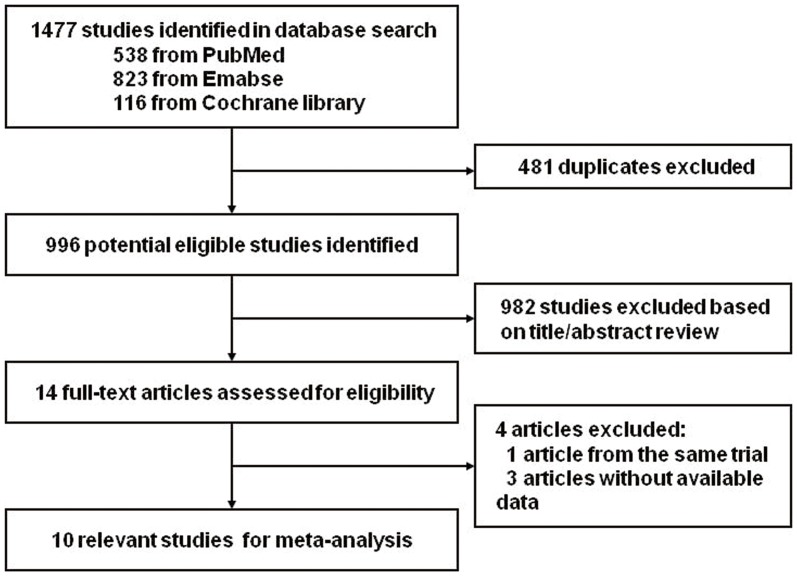
PRISMA Flow Chart.A total of 14 articles were identified and articles from the same trial and 3 articles without available data, thus 10 studies were suitable.